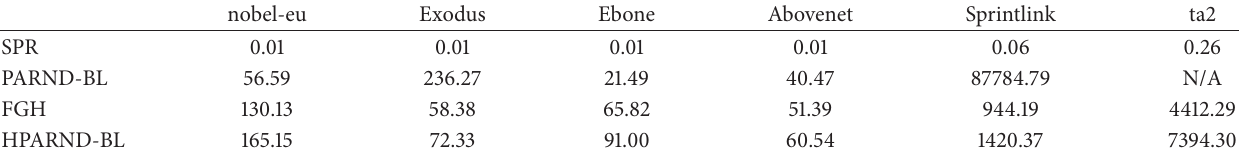
Table 9: CPU times (s)—cubic curve.